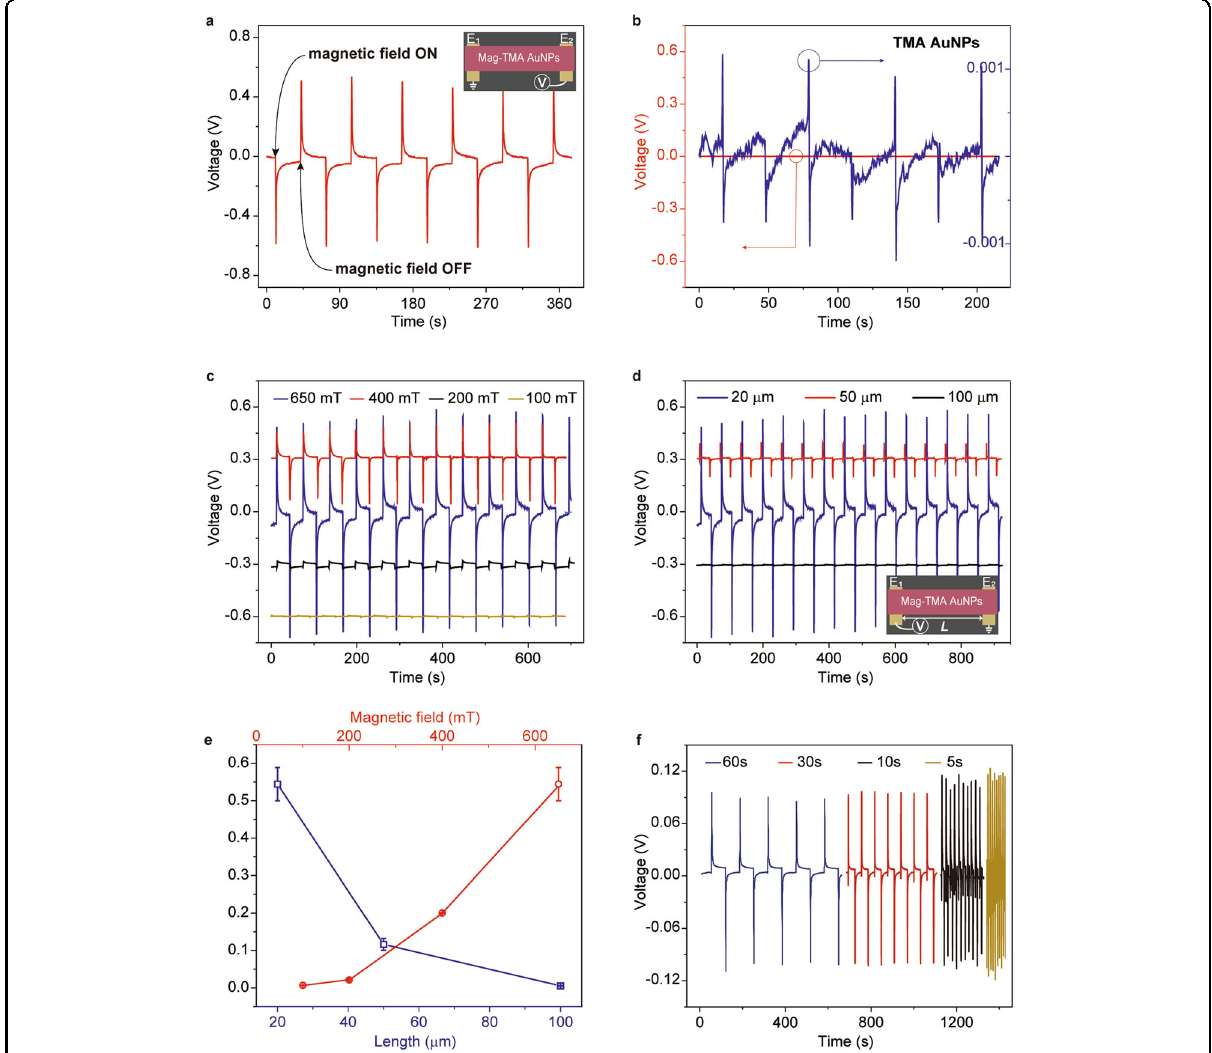
Fig. 2 The electrical output of the mag-TMA AuNP nanogenerator. a Open-circuit voltage of the mag-TMA AuNP nanogenerator when the magnetic fi eld is applied (ON) and removed (OFF). b The output characteristics of a control device fabricated by using TMA AuNPs in which the counterions (Cl − ) are nonmagnetic. The red curve (left y-axis) is magni fi ed and replotted in the blue curve (right y-axis). c , d Dependence of open- circuit voltages on the strength of the magnetic fi eld ( c ) and channel length L between two electrodes ( d ). For the sake of clarity, the red/black/ yellow curves are manually shifted upward/downward by 0.3 V/0.6 V. All of the channel lengths in ( c ) are 20 μ m, and the magnetic fi elds in ( d ) are 650 mT. e The open-circuit voltage amplitudes as a function of channel length (blue curve, bottom x-axis) and magnetic fi eld strength (red curve, top x-axis). f The dependence of open-circuit voltages on the frequencies of the ON/OFF magnetic fi eld. All of the channel lengths are 50 μ m, and the magnetic fi elds are 650